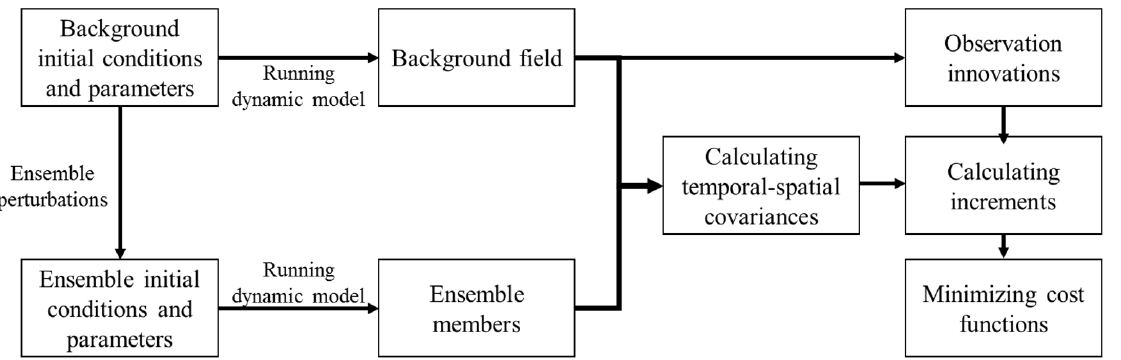
Figure 1. The flowchart of proposed A-4DEnVar. The ensemble initial conditions and parameters are generated by adding small perturbations to the background initial conditions and parameters, respectively. After integrating the dynamic model, the ensemble temporal-spatial covariances are calculated to replace the adjoint models in 4DVar. Using the analytical solutions of cost function, state variable and parameter increments are obtained. The linear search processes are conducted to minimize the cost